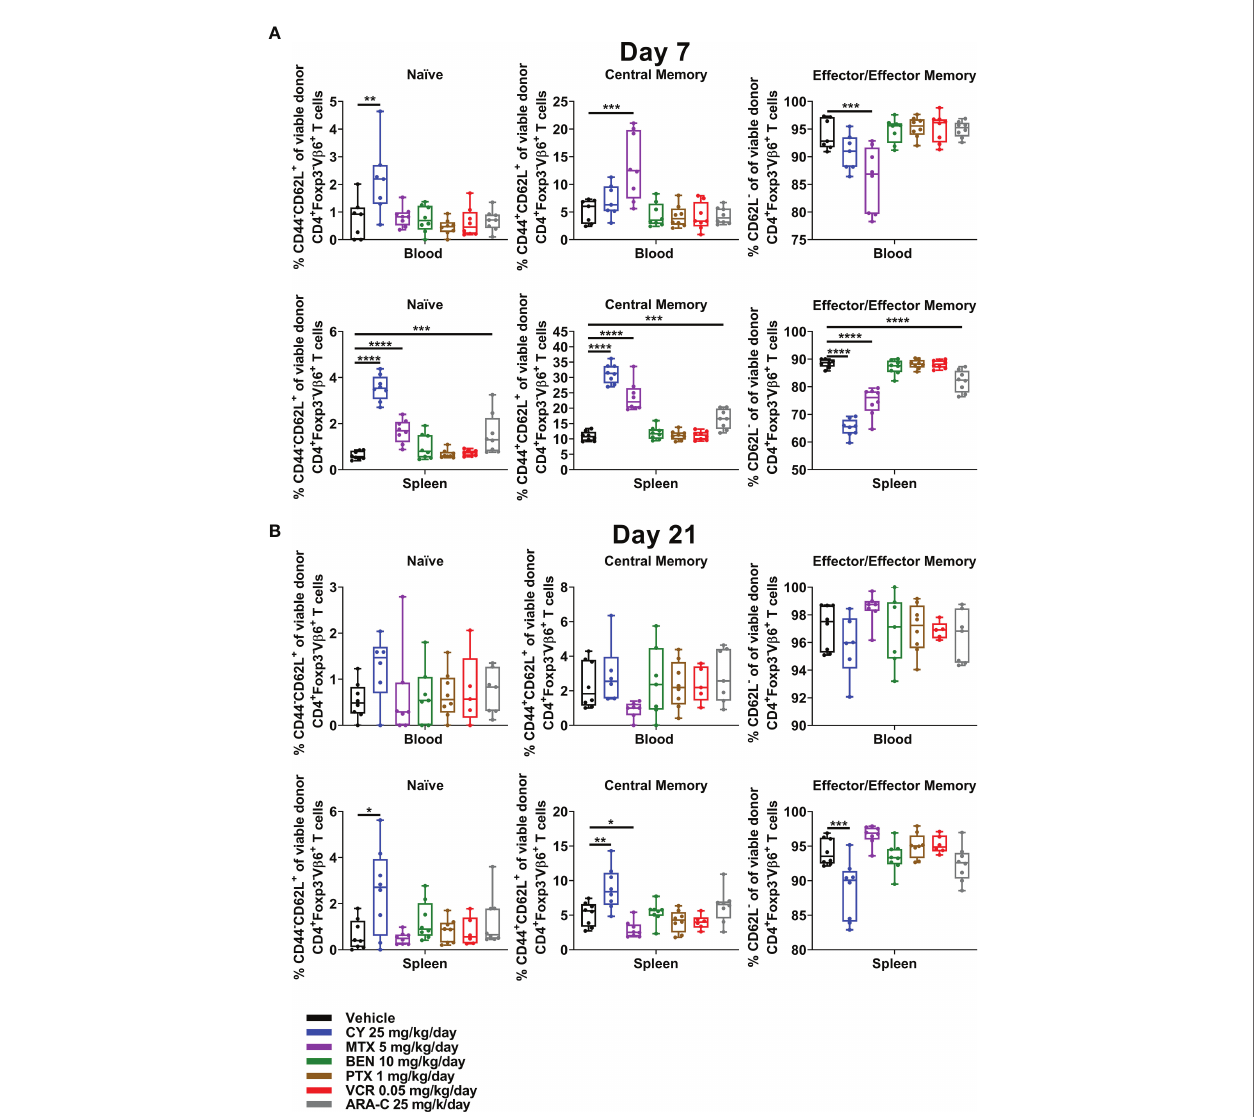
FIGURE 7 | CY uniquely restrains T-cell differentiation at both early and later timepoints. Mice were transplanted, treated with PBS or a chemotherapeutic on days +3 and +4, and euthanized for fl ow cytometric assessment at day +7 or +21 as in Figure 3 . (A) At day +7, CY decreased percentages of CD4 + Foxp3 - V b 6 + T cells that were phenotypically effector/effector memory (CD62L - ). Consequently, percentages of naïve (CD44 - CD62L + ) and central memory (CD44 + CD62L + ) CD4 + Foxp3 - V b 6 + T cells were increased by CY at day +7. This same effect was achieved to a lesser extent after both MTX and ARA-C. (B) This restrained differentiation was persistent after CY at day +21 but was completely lost after MTX, wherein differentiation seemed to be overall accelerated. Combined results from two independent experiments are shown with n = 4/group/experiment except for VCR (n = 6 total) in (B) due to excess early deaths. *p < 0.05, **p < 0.01, ***p < 0.001, ****p < 0.0001 on one-way ANOVA followed by the Holm-Sidak post hoc test using the vehicle-treated group as the control. Only signi fi cant results are shown; all other comparisons between treatment groups and the vehicle group are non-signi fi